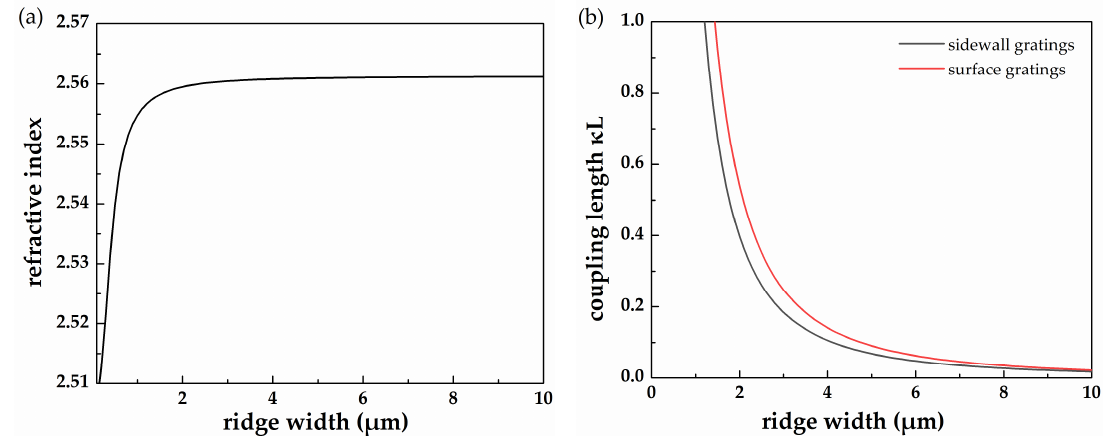
Figure 2. ( a ) Refractive index as a function of the ridge width. ( b ) Coupling length kL as a function of Figure 2 ( a ) Refractive index as a function of the ridge width . ( b ) Coupling length ĸL as a function of the ridge width of the sidewall and surface gratings. Etching depth: 500 the ridge width of the sidewall and surface gratings . Etching depth: 500 nm.